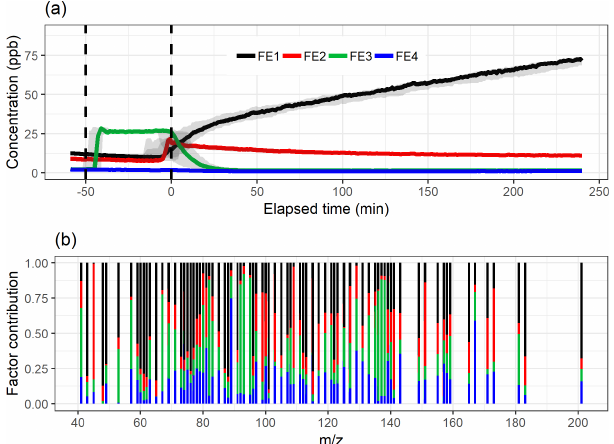
Figure 3. The factor time series (a) and contribution (b) for ml- EFA with oblimin rotation for the four-factor solution. Shaded areas in the time series indicate the factor range for the bootstrap resam- ples; solid lines are for the measured gas-phase (PTR-MS) data. The colour code identifying factors is the same in both panels. Factors were identified as later-forming and slowly forming products (FE1), early products (FE2), α -pinene precursor (FE3), and background or car exhaust precursor